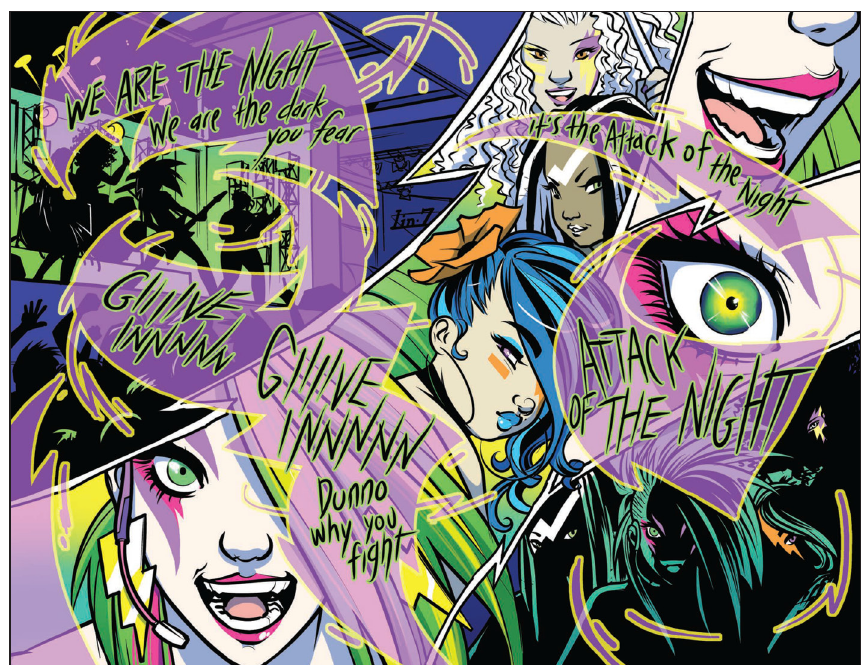
Figure 1: A Misfits music video Showtime (Thompson and Campbell, 2015. © Hasbro